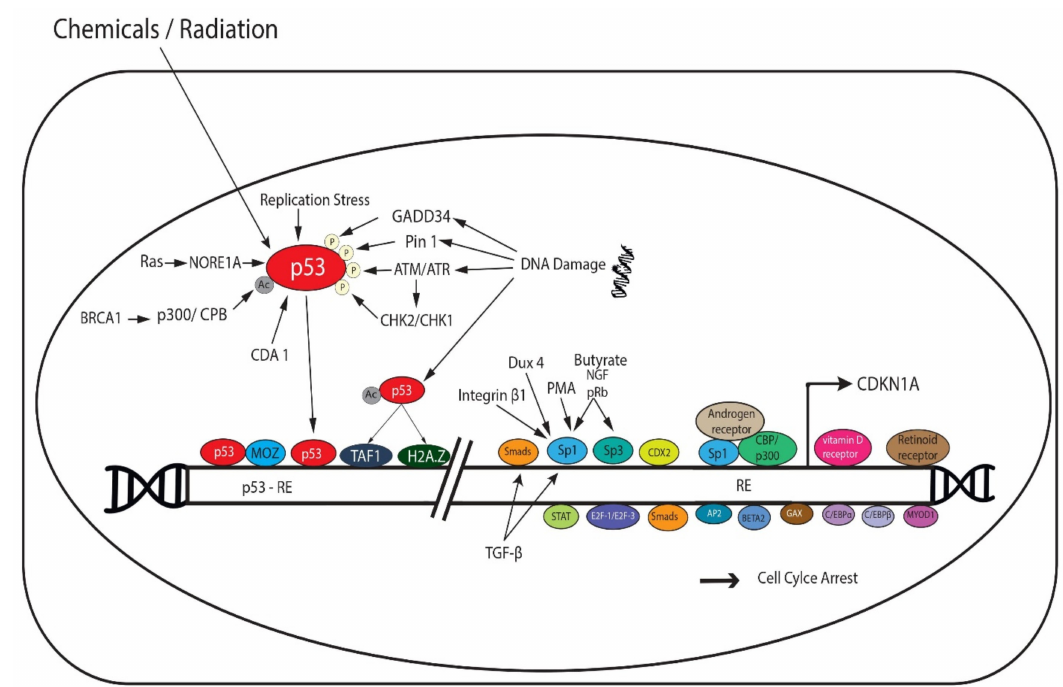
Figure 1. p53-dependent and p53-independent transcriptional regulation of p21. Chemicals, radiation, replication stress, and DNA damage induce the activity of p53. As a result, p53 activates the transcription of p21 by directly binding highly conserved p53-responsive elements (p53-RE) found in the p21 promotor. Acetylated p53 recruits TFIID subunit, TAF1, to the p53-RE on p21 in response to DNA damage. BRCA1-recruited p300 / CREB-binding protein (p300 / CBP) coactivator family mediates the acetylation of p53 and the activation of p21 gene. p53 recruits the histone variant H2A.Z to promote p21 transcription. p53isphosphorylatedandactivatedbyATM-CHK2, andATR-CHK1pathwaysinresponse to DNA damage. Pin1 and GADD34 promote the phosphorylation and stability of p53, and hence the transcriptional activation of p21 following DNA damage. Cell division autoantigen 1